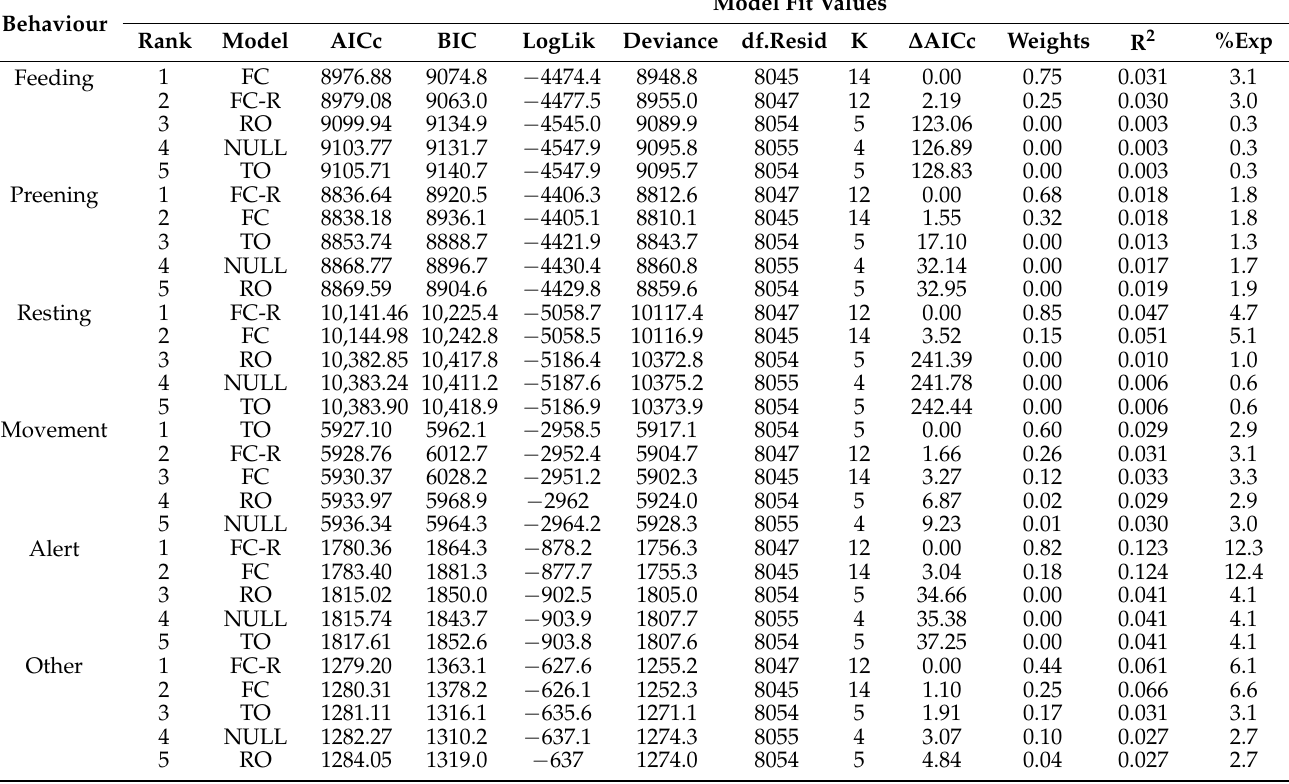
Table A1. Model fit values of binomial GLMMs explaining chicks performance of key state